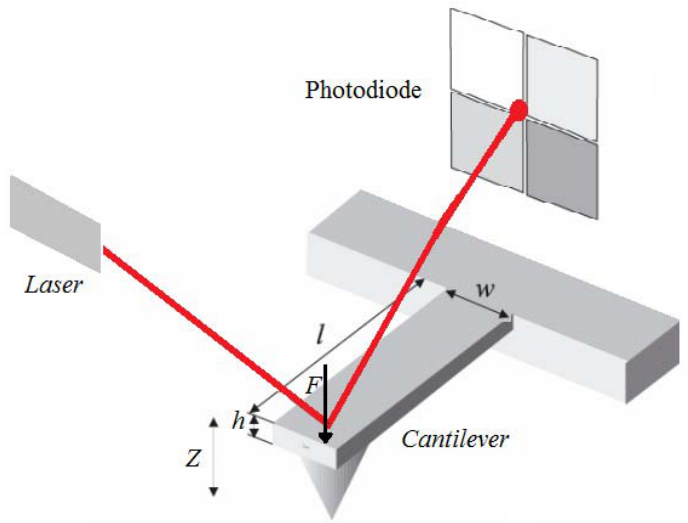
Figure 5. Illustration of the displacement of the cantilever (h, w and l, thickness, width and the length of the cantilever,